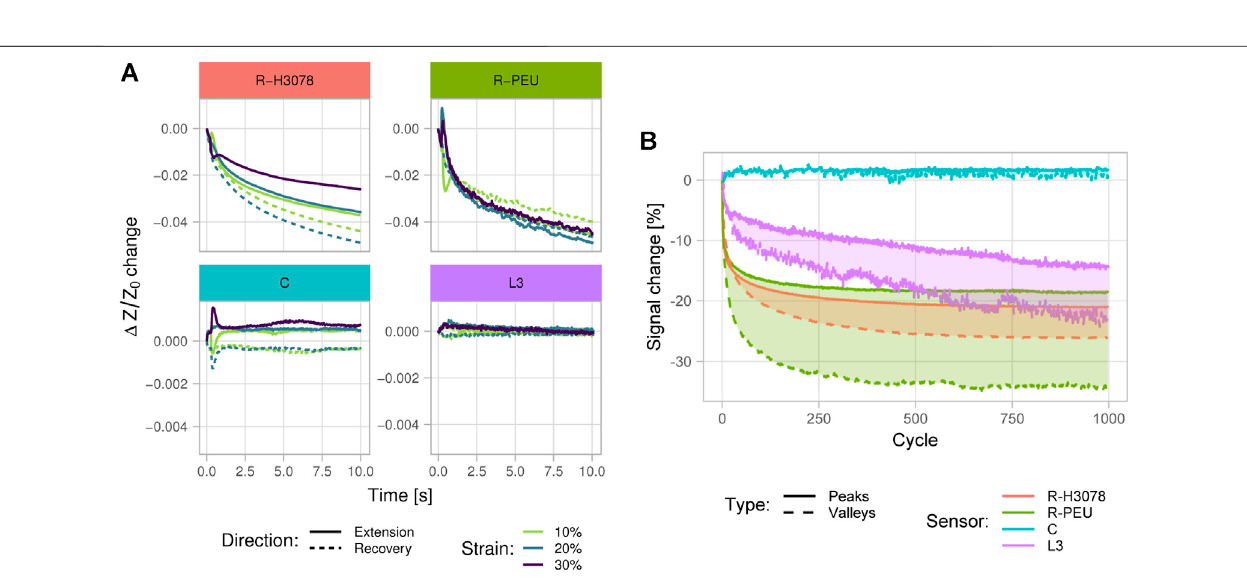
Frontiers in Materials |